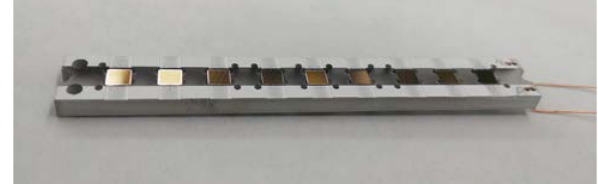
Fig. 2. Array containing 9 SiPMs. Two sputtered aluminum traces connect the SiPMs, which are read out in parallel. The substrate is suprasil, a fused silica